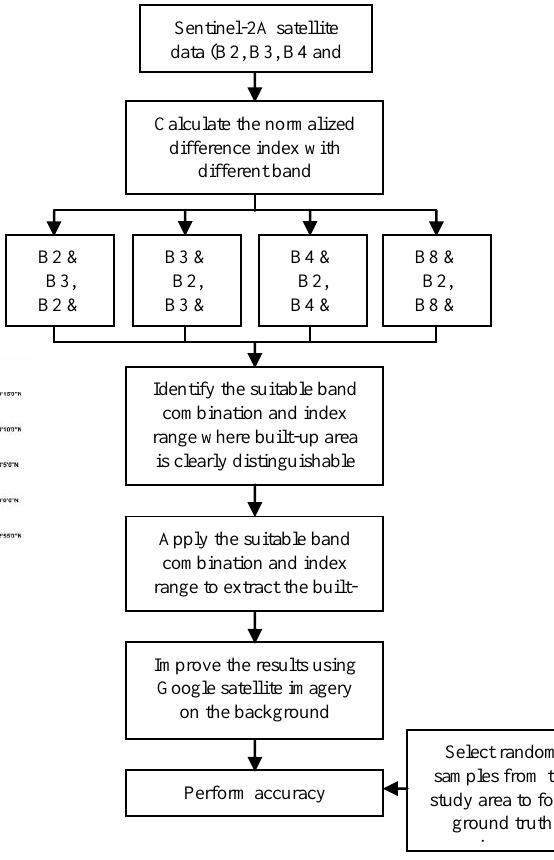
Figure 2. Flowchart showing the proposed methodology The four bands of high resolution Sentinel-2A covering the study area is the input satellite data used in the present